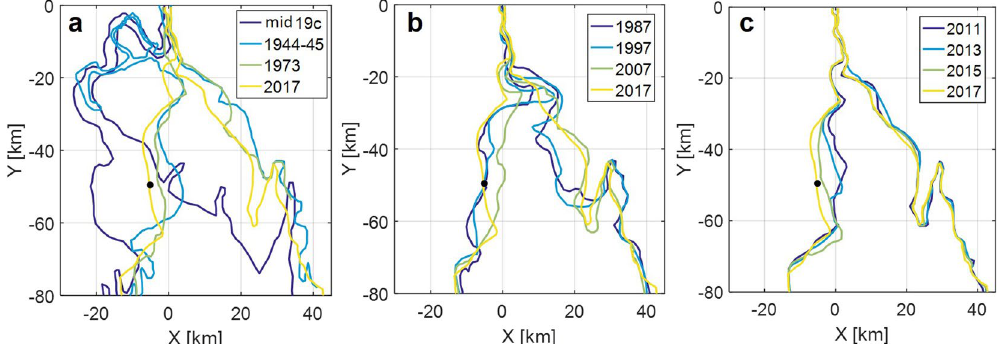
Figure 2. Evolution of Sittang River estuary on different time scales. These coastlines represent vegetation lines extracted from Landsat imagery. Two old coastlines (1940’s and mid 19 th century) were derived from old printed maps. Black dot indicates survey site at Mamauk. Supplememtary Fig. S2 provides comparisons of two successive coastlines for each figure. ( a ) Centennial changes. ( b ) Multidecadal changes. ( c ) Intradecadal changes. Figures were created using MATAB ver. R2006b from Mathworks